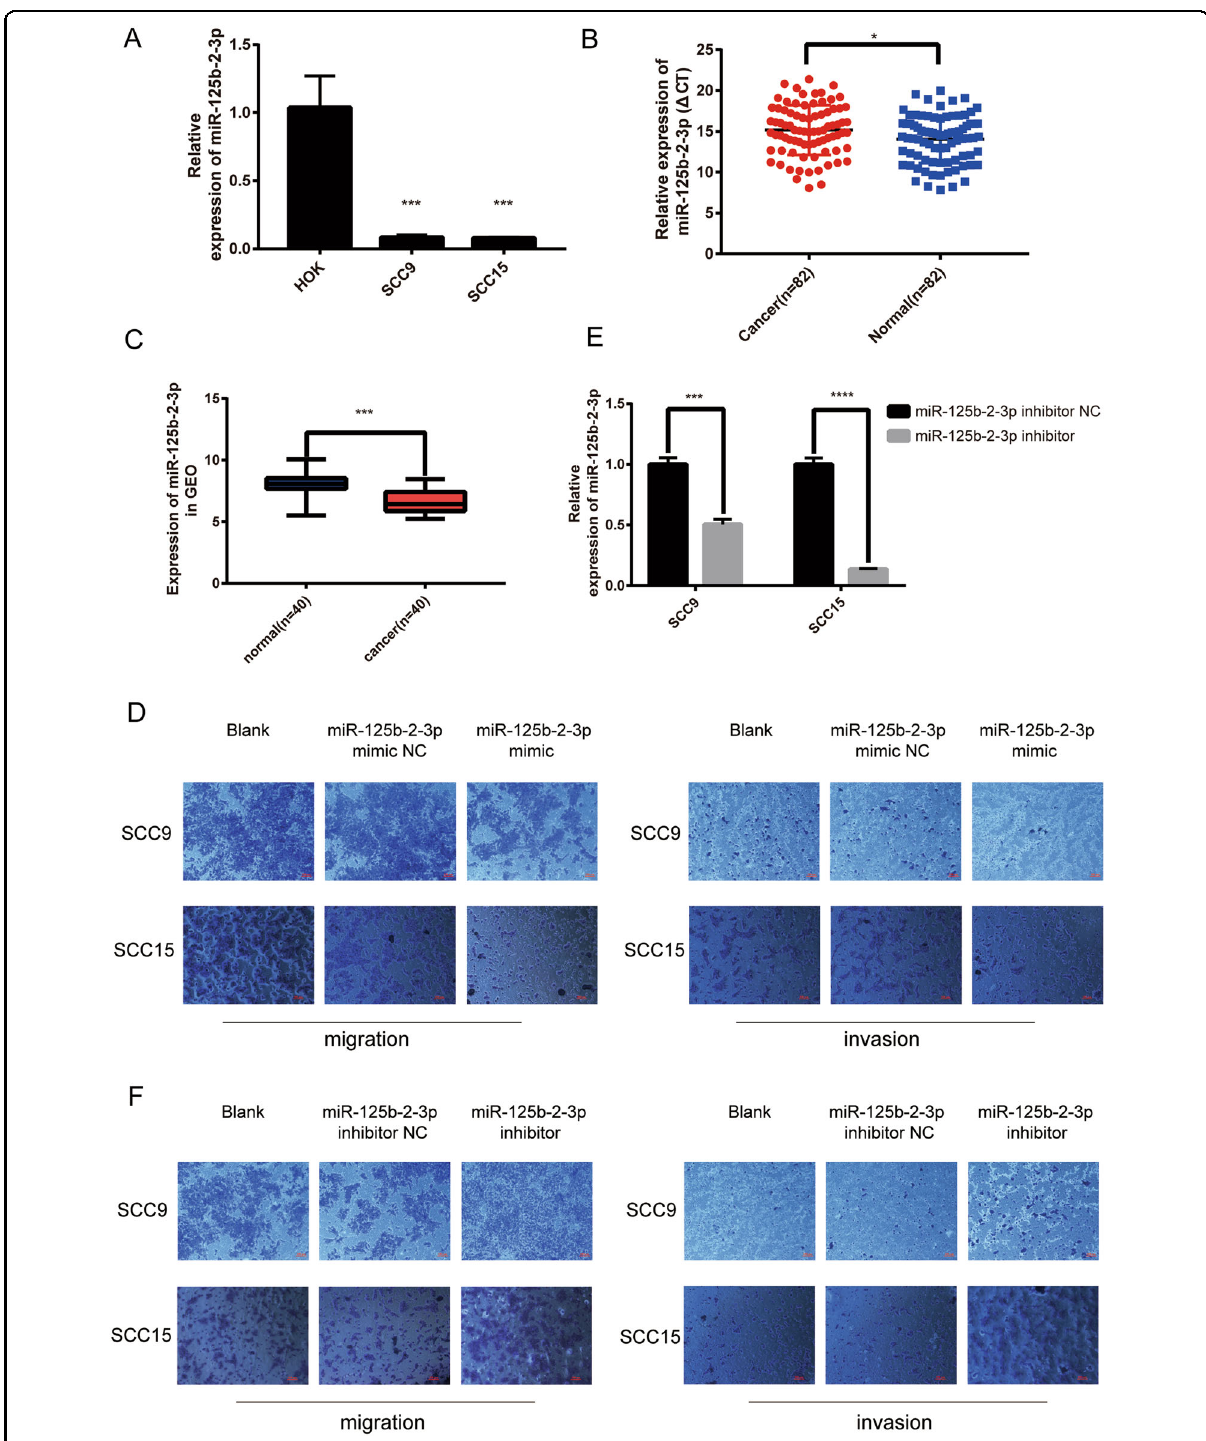
Fig. 3 MiR-125b-2-3p regulated migration and invasion in OSCC cells. a Lower expression of miR-125b-2-3p was detected in two OSCC cells compared to HOK cells. b Differential expression of miR-125b-2-3p in 82 pairs of OSCC clinical samples (Higher Δ CT means the lower relative expression of miR-125b-2-3p). c The expression data of miR-125b-2-3p in 40 pairs of OSCC in GEO database. d Overexpressing miR-125b-2-3p inhibited the migration (left) and invasion (right) in SCC9 and SCC15. e The inhibition ef fi ciency of miR-125b-2-3p inhibitor in SCC9 and SCC15 cells. f Inhibiting the expression of miR-125b-2-3p promoted the migration (left) and invasion (right) ability in SCC9 and SCC15. * p < 0.05, ** p < 0.01, *** p < 0.001, **** p <